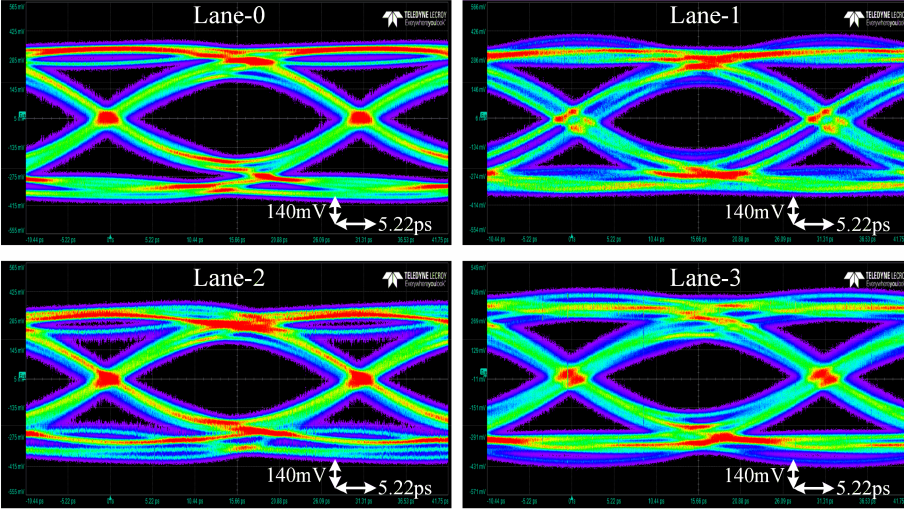
Figure 10. Measured output eye diagrams of the proposed TX lane-0/1/2/3 at 32